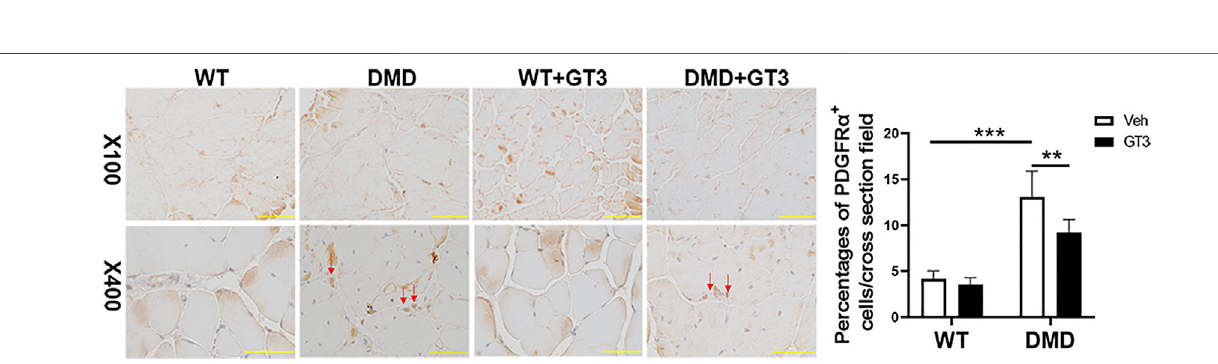
FIGURE9| EffectofGT3onCD45positivecellsinthetibialisanteriorofDMDmice.CD45positivecellswerelabeledinthetibialisanteriorcellsandtheeffectofGT3 treatment on the number of CD45 positive cells was compared. Data were presented at means ± SEM ( n = 6) with two-way ANOVA analysis. *** p < 0.001.